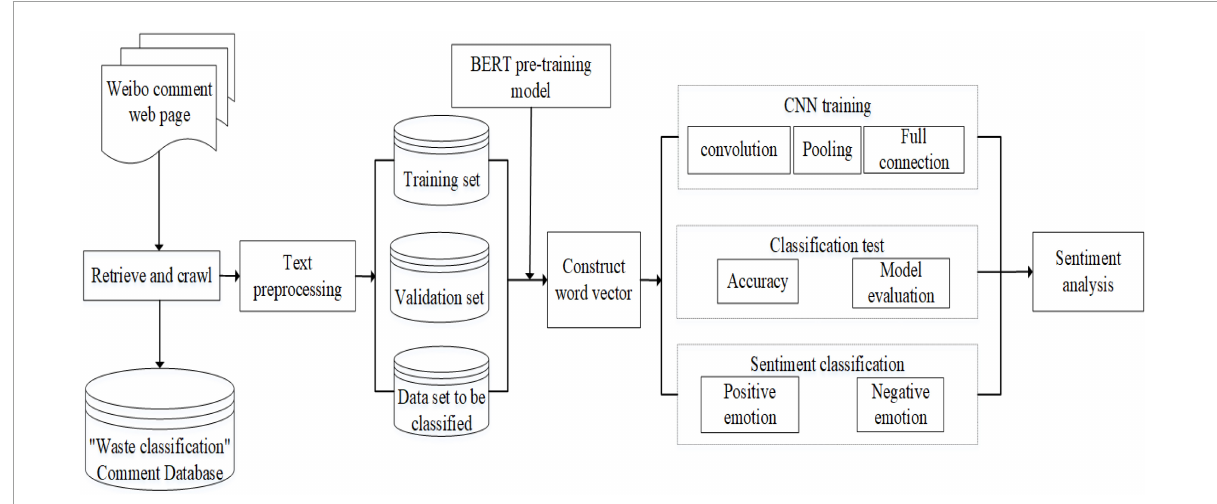
FIGURE4 Emotional tendency analysis model based on